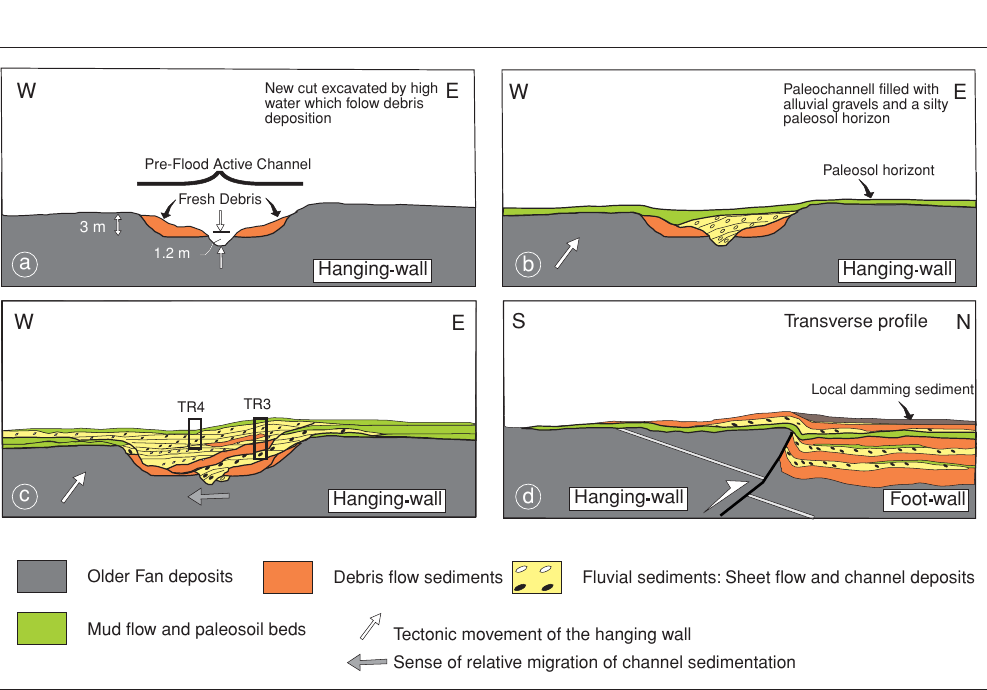
Fig. 8a-d. Model showing sedimentary development of an active debris-fluvial channel in an oblique-slip fault zone. The channel dimensions and the morphology of debris sedimentation are taken from the description of Beaty (1963, 1990) for the upper Milner Creek fan. The activity of the fault controls the drainage pattern and behaviour (erosional/depositional in areas undergoing tectonic uplift/subsidence). The ideal sections A, B and C are drawn parallel to the fault (in the hanging-wall) and show that the left-lateral and reverse movement on the fault zone causes the channel to produce vertical and lateral incision. Section D is transverse to the fault and show the sedimentation of pounded deposits of unit A due to the obstruction of the